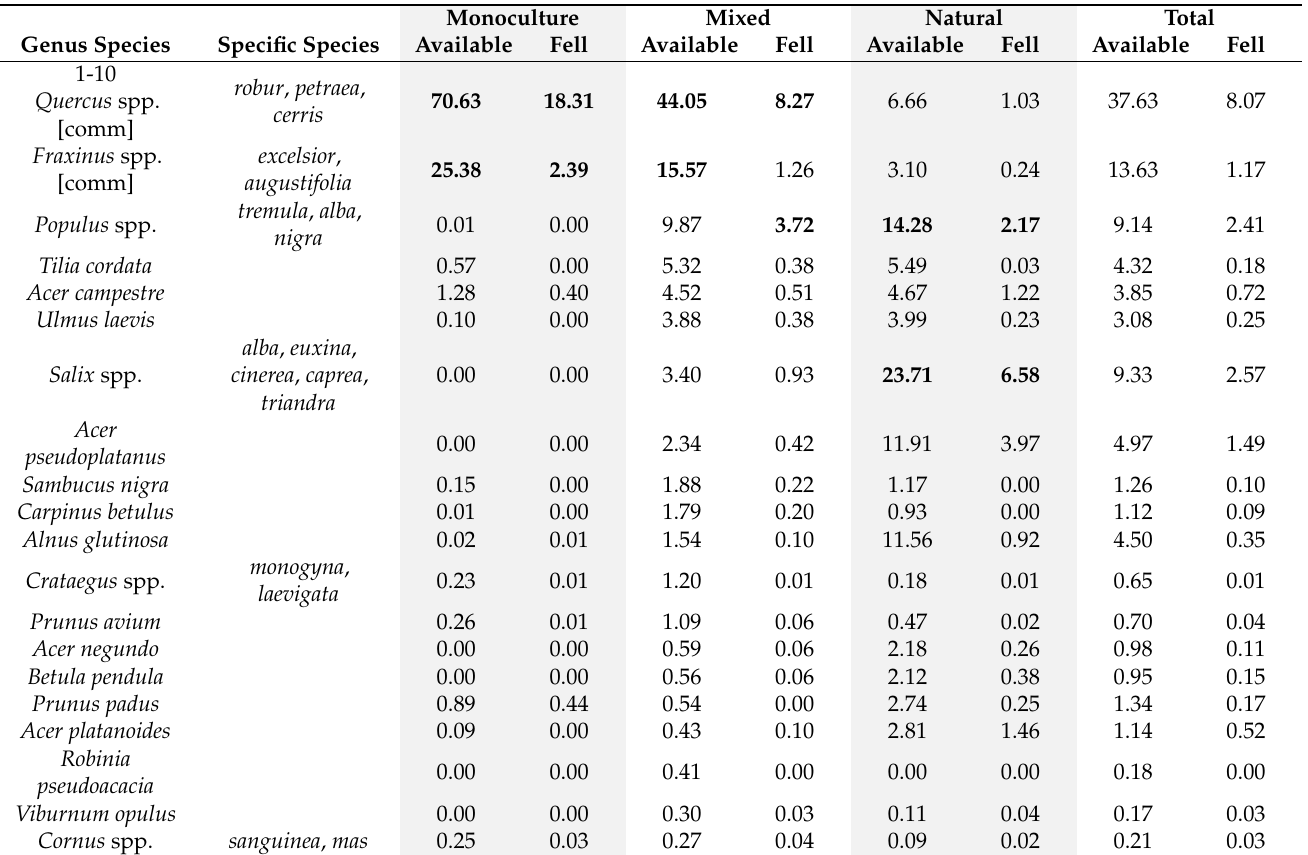
Table 1. Availability of woody plants (Available; % basal area) and the proportion felled by beavers (Fell; % basal area) in different patch/forest stands. [comm]—main commercial